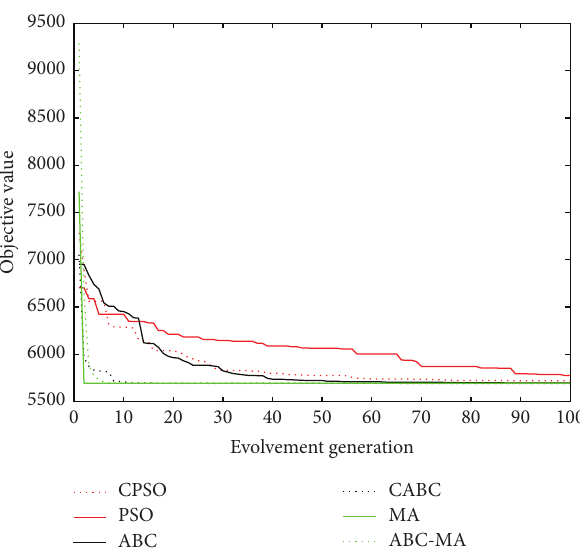
Figure 15: The convergence curve of the survival data.